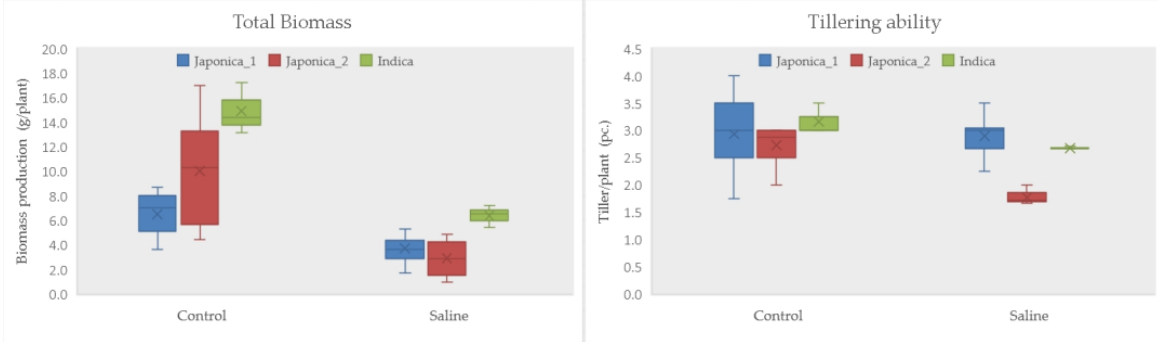
Figure 2. Total biomass production and tillering ability under control and saline treatment among rice varietal groups.